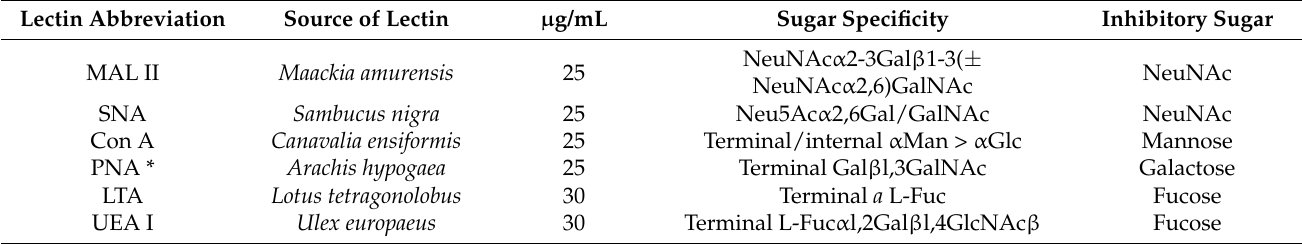
Table 2. Lectin used, their sugar specificities and the inhibitory sugars used in control experiments. Lectin Abbreviation Source of